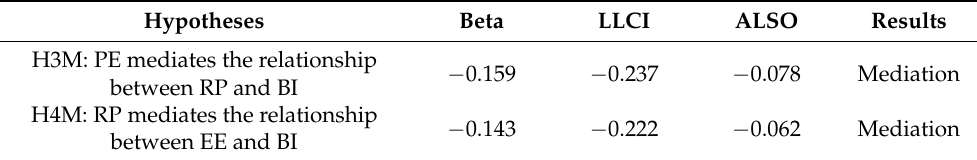
Table 5. Results of